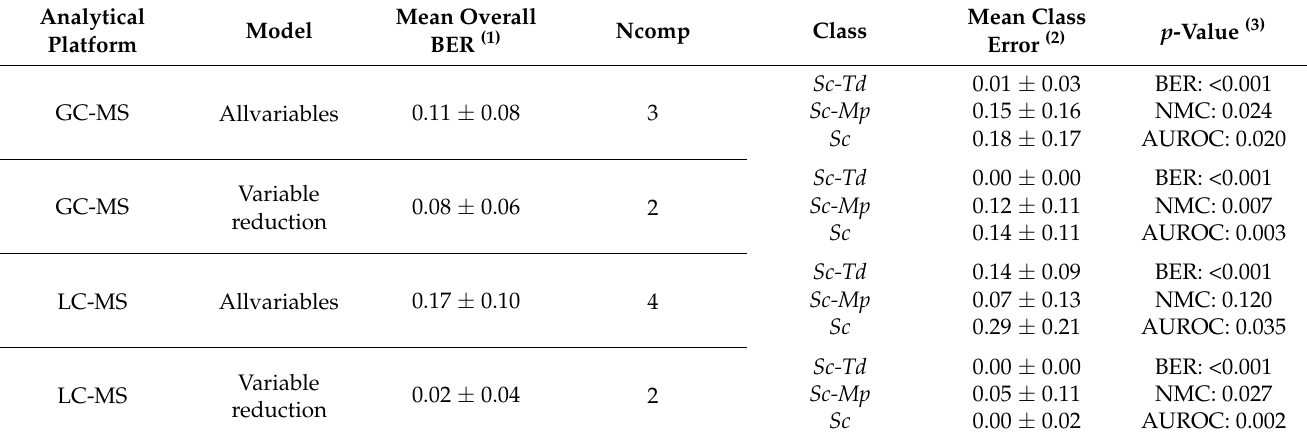
Table 1. Model performance of the partial least squares discriminant analysis (PLS-DA) models built to discriminate yeast fermentation strategy and grape variety used to elaborate the ros é wine